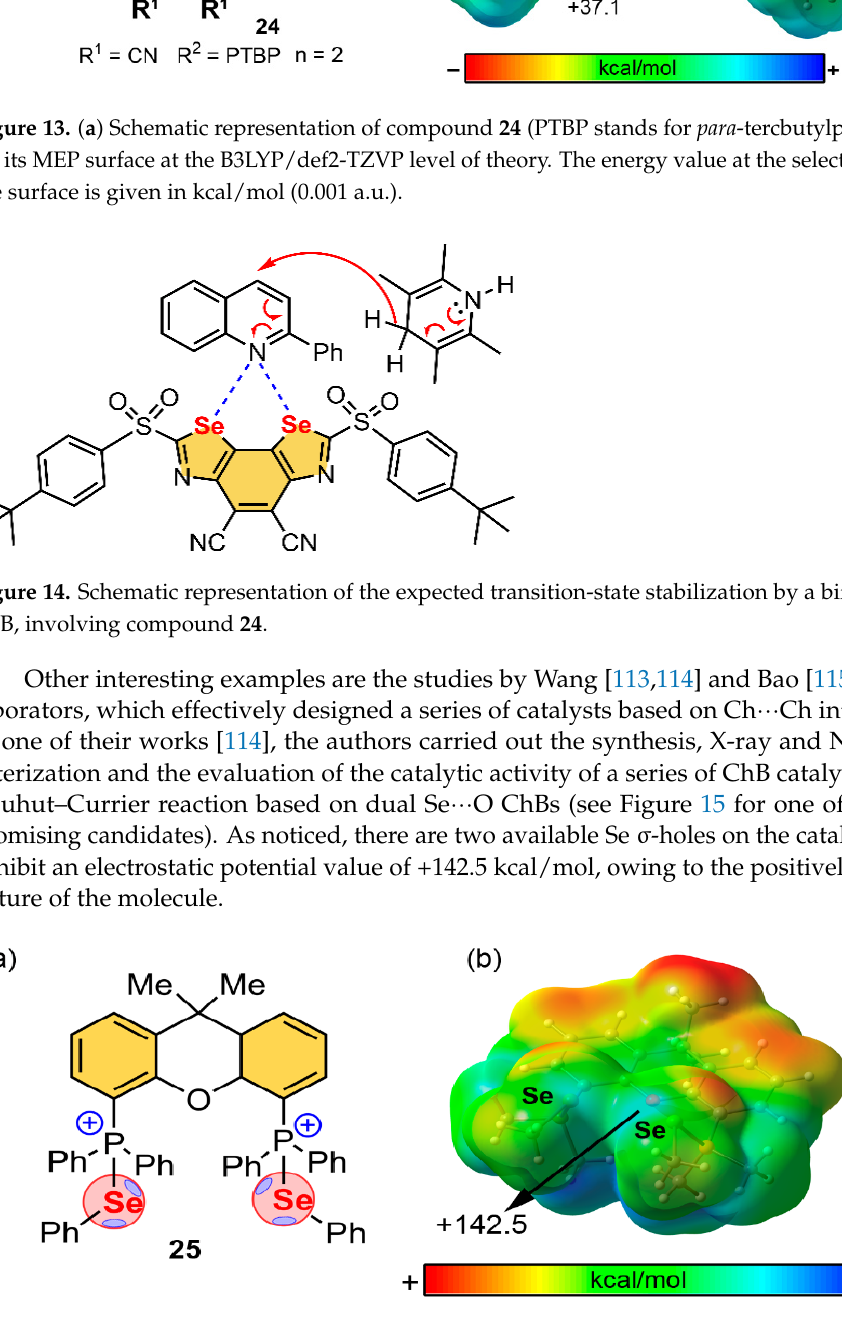
Figure 15. ( a ) Schematic representation of compound 25 and ( b ) its MEP surface at the B3LYP/def2- TZVP level of theory (Ph groups have been replaced by Me groups for sake of clarity). Energy value in kcal/mol (0.001 a.u.).